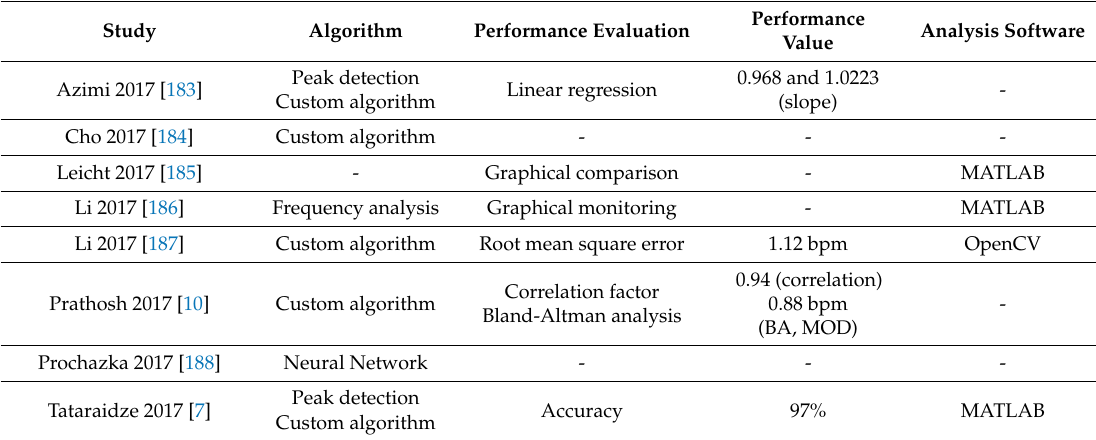
Table A5. Analysis of the processing algorithm, performance evaluation, and software for the studies of the environmental category published before